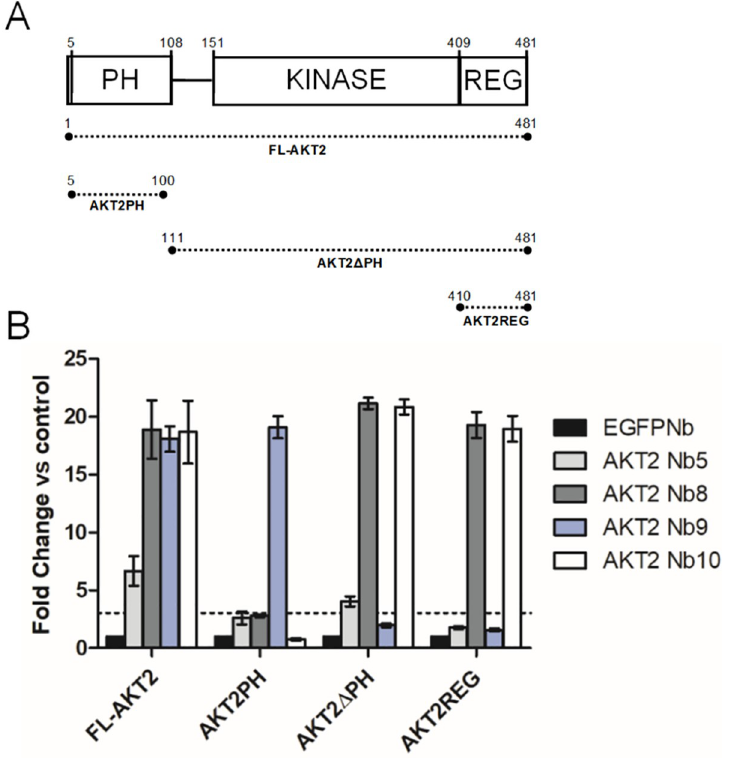
Fig 4. Epitope mapping of AKT2 Nbs. (A) Illustration of the AKT fragments used for epitope mapping. (B) ELISA: Mean and 95% CI of normalized OD plotted for full-length AKT2 (FL-AKT2), the AKT2 PH domain (AKT2PH), a fragment consisting of the flexible linker, kinase domain and regulatory domain (AKT2 Δ PH) and the regulatory domain (AKT2REG). Target proteins were coated in wells of a 96 multiwell plate in quadruplicate for each AKT2 Nb and the EGFP Nb (negative control). All measured OD’s were normalized for the negative control. A Nb was considered to be an interactor when the average normalized OD was at least three times that of the negative control for the same AKT2 fragment (dashed